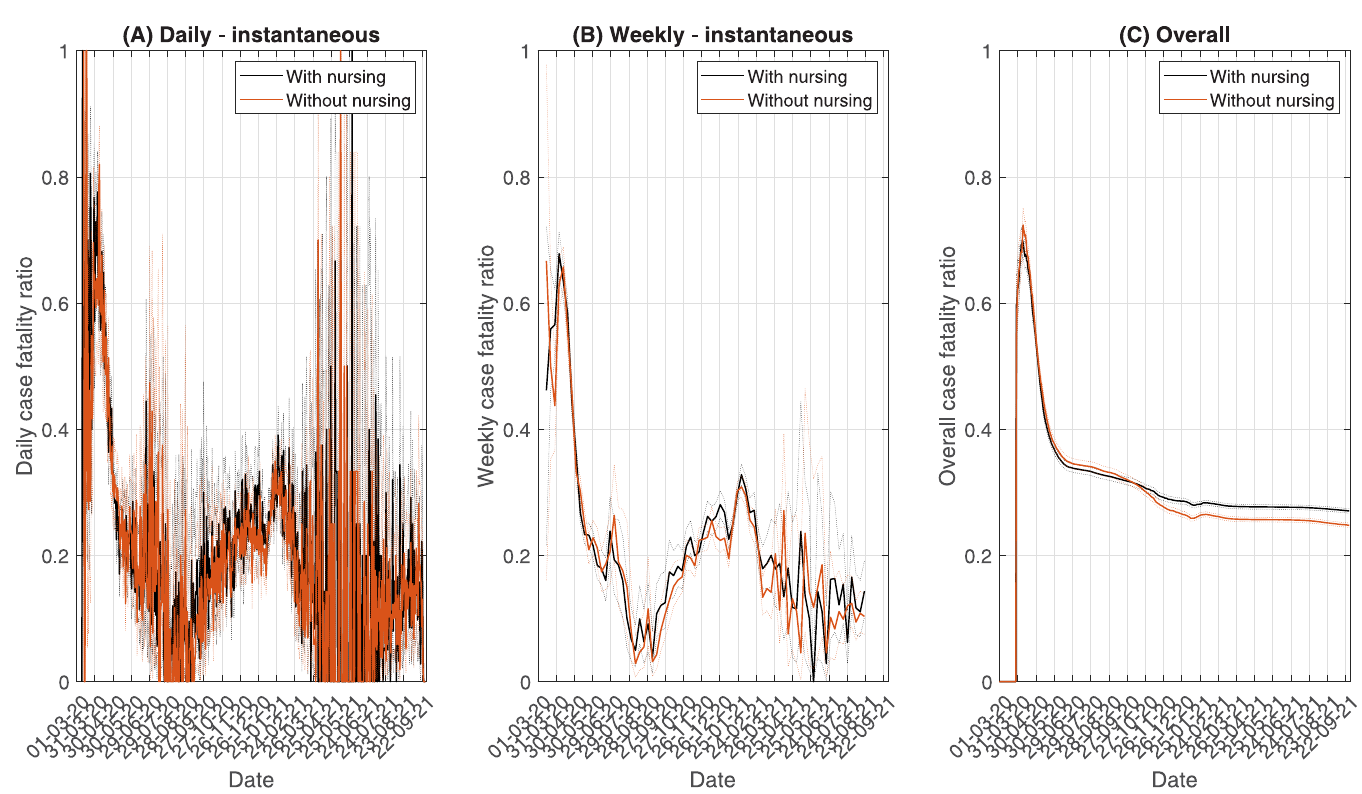
Fig 7. CFR based on type of care: With nursing or without nursing, using PHE data and backward methods. (A) shows the daily instantaneous CFR, (B) shows the weekly instantaneous CFR, and (C) shows the overall CFR over time. Dashed lines indicate the 95% confidence intervals.